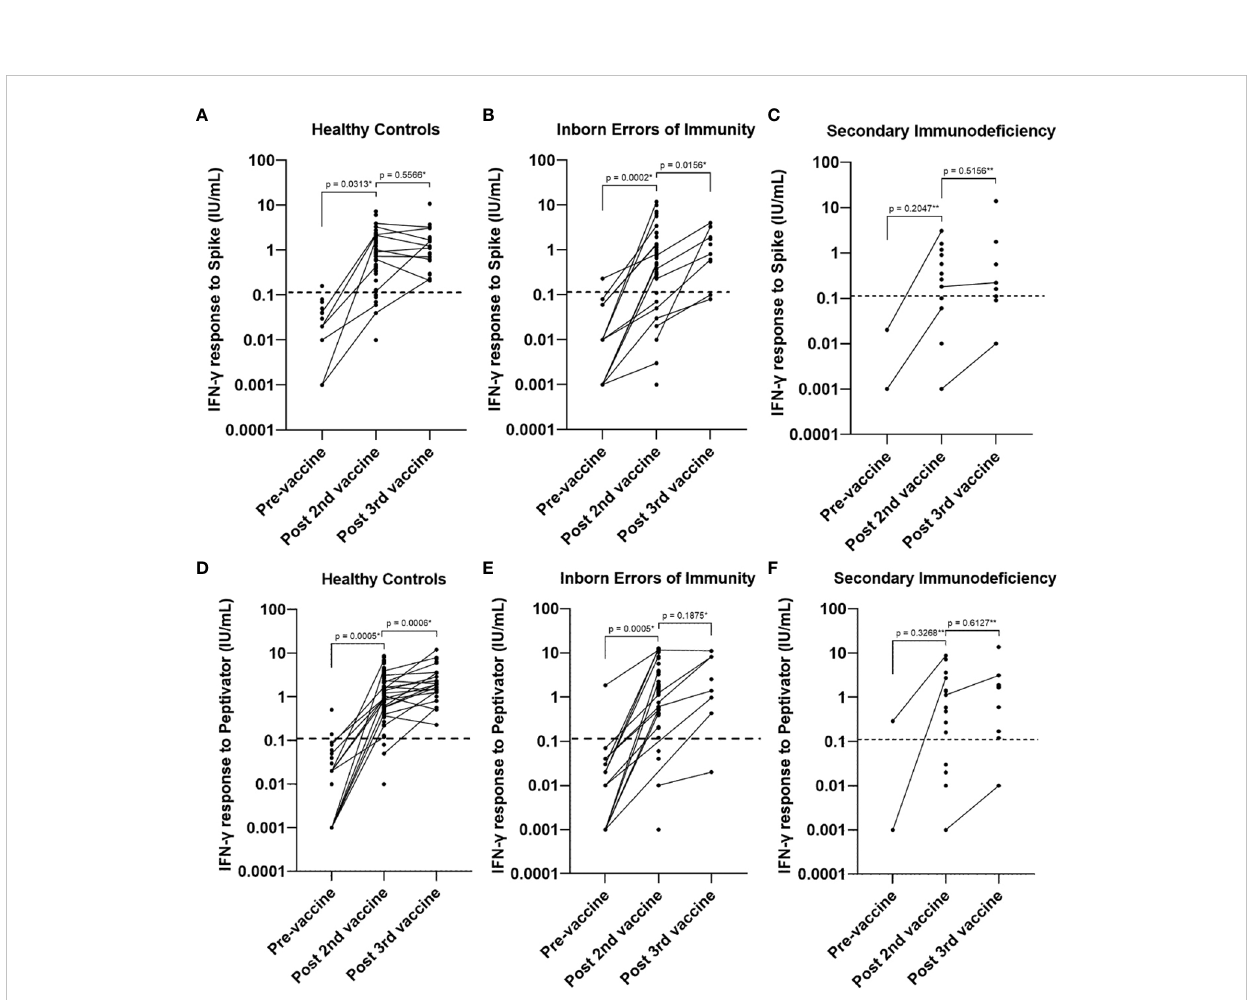
FIGURE 6 Longitudinal studies of interferon gamma response levels to (A – C) . spike protein stimulation and (D – F) . peptide (S, S1, S+) mix stimulation pre- vaccine, post primary vaccination and post booster vaccine in healthy controls, individuals with inborn errors of immunity and individuals with secondary immunode fi ciency. Individual values are plotted on a logarithmic scale (log 10). The dashed line represents the lower limit of the validated reference range (0.11IU/ml). * Wilcoxon test (paired). ** Mann-Whitney U Test